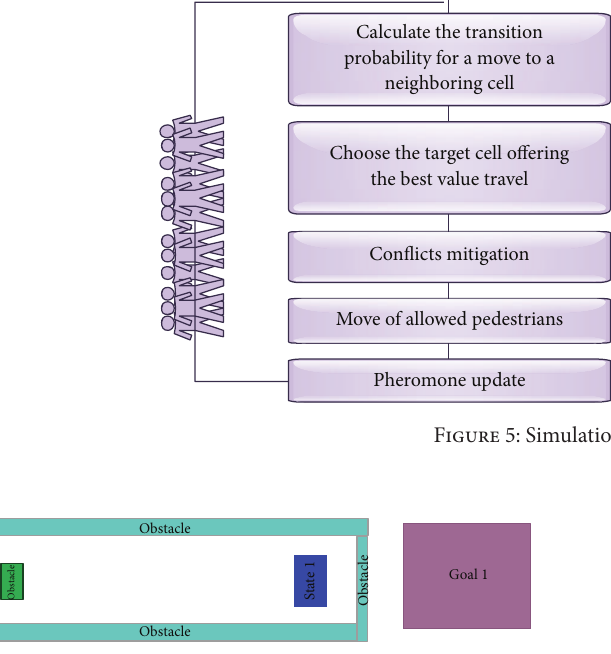
Figure 6: Simulation scenario as a blocked corridor.